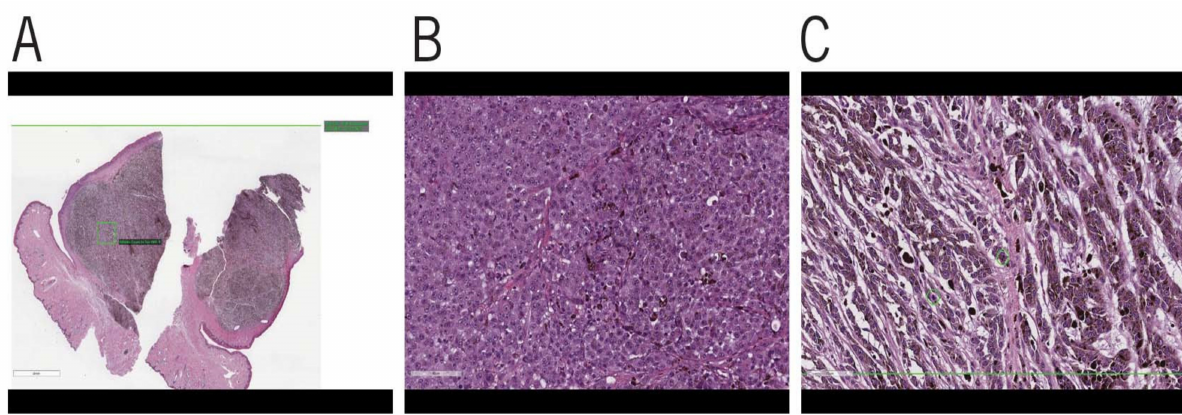
Figure 2. Histopathologic features of OMM: ( A ) Low magnification, bar = 4 mm. Lightly pigmented mass beneath mucous membrane. Mitotic count of 9 per 10 high powered fields (2.37 mm 2 ). The area framed by the green lines denotes the area assessed by the artificial intelligence (AI) software used by Antech diagnostics to calculate mitotic index (MI) in addition to manual counts done by the pathologists in the same field as a cross-check. The green circles indicate a location where mitotic figures were noted by the AI system. ( B ) Moderate magnification, bar = 90 um. Poorly pigmented tumor cells with moderate to marked nuclear atypia, large prominent nucleoli, and numerous mitotic figures. ( C ) High magnification, bar = 70 um. Lightly pigmented tumor cells with mildly pleomorphic oval nuclei and prominent nucleoli. Green circle indicates a location where mitotic figures were found by the AI software used by Antech diagnostics to calculate